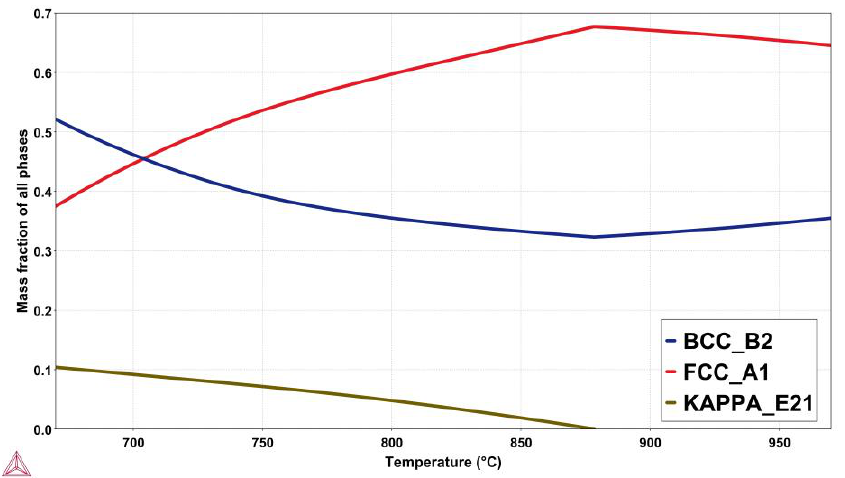
Figure 1. CALPHAD calculations of the equilibrium quantity of phases in the steel studied at oxi- dation temperatures.